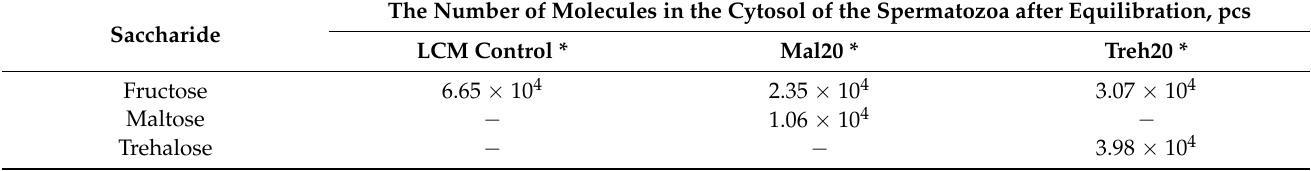
Table 4. Theoretical number of molecules in the cytosol of each spermatozoa after equilibration for 40 min, pcs. Saccharide